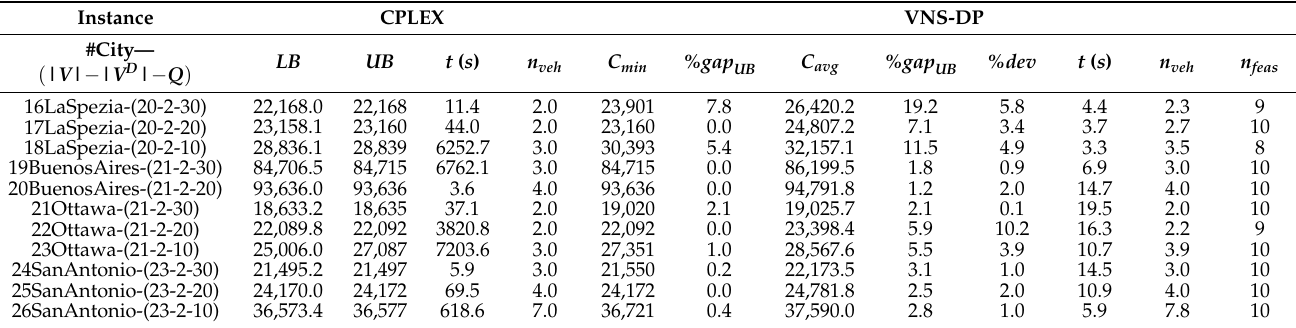
Table 5. Results for medium-size benchmark